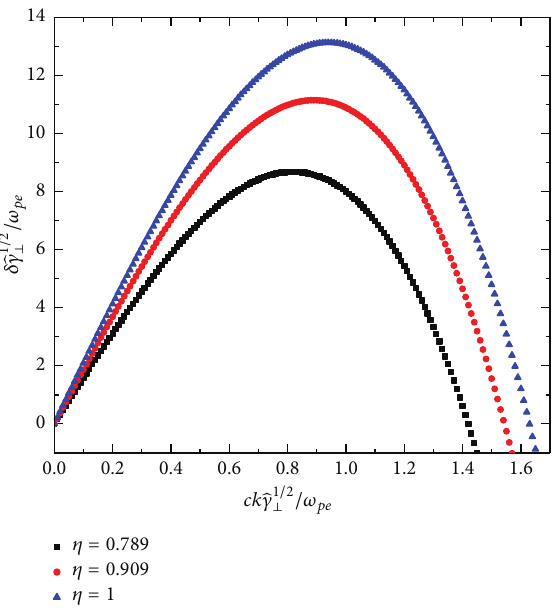
Figure 2: The variation curves of 𝑇 ⊥ according to the quantity 𝛼 for different values of ̂𝛾 ⊥ .